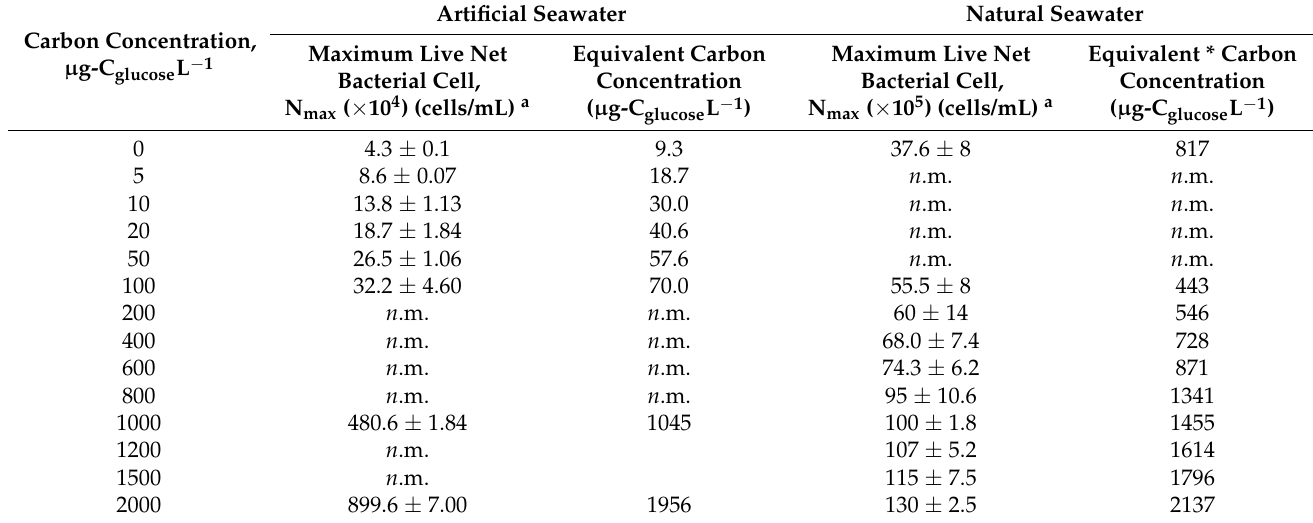
Table 4. Maximum bacterial cell concentration (N max ) and equivalent carbon concentration (ECC) in artificial and natural